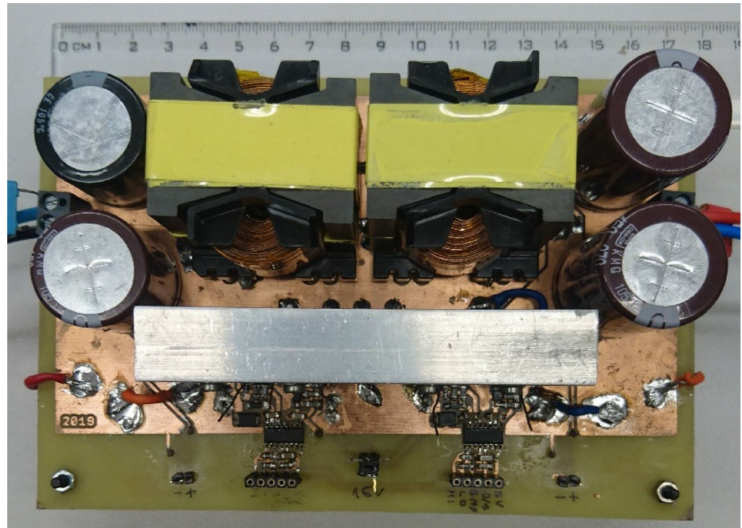
Figure 10. Experimental prototype of the non-modular bidirectional